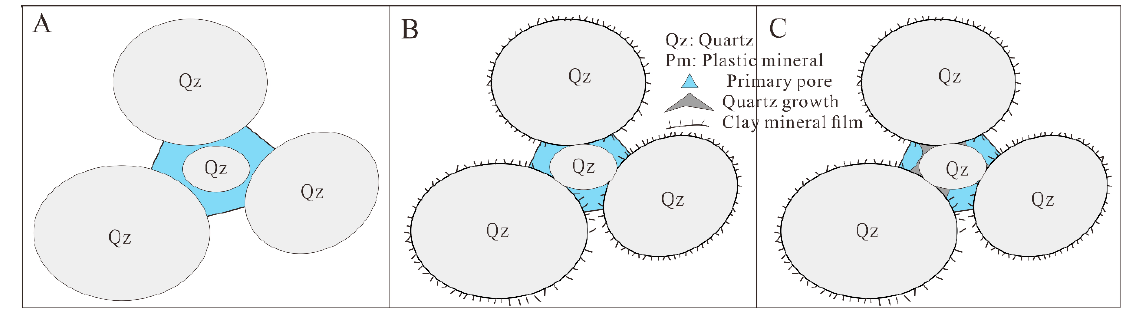
Figure 13. Influences of clay mineral rim on quartz sandstone. ( A ) the primary intergranular pore between quartz grain; ( B ) the primary intergranular pore between quartz grain preserved by the clay mineral film; ( C ) the primary intergranular pore between quartz grain preserved by the clay mineral film and siliceous cements.